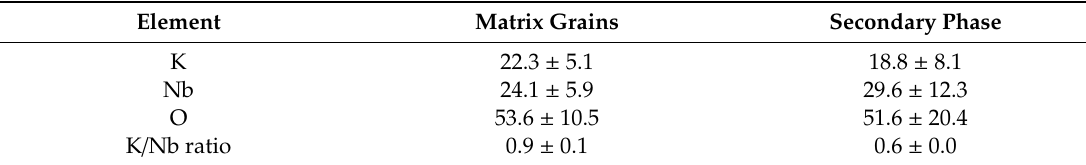
Figure 4. SEM micrographs of the edges of KNbO 3 samples sintered at 1040 ◦ C for 10 h in different atmospheres. Table 1. EDS analysis of matrix grains and secondary phase in a KNbO 3 sample sintered at 1040 ◦ C for 10 h in H 2 .